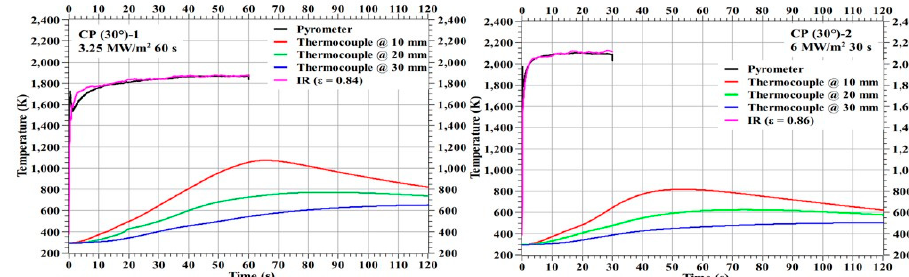
Figure 11. CP (30°)-1 and CP (30°)-2 temperature responses.